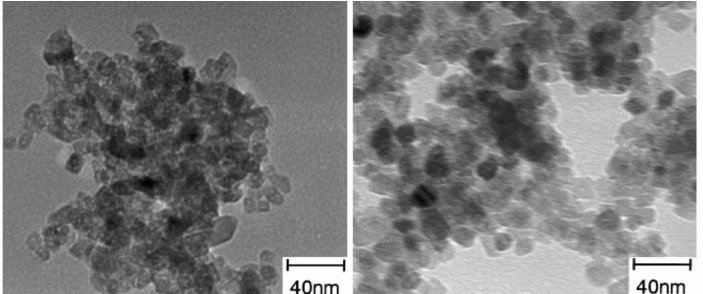
Figure 5. TEM images of the oxide system 90%TiO 2 -10%ZrO 2 (created based on [85] with permission from Elsevier